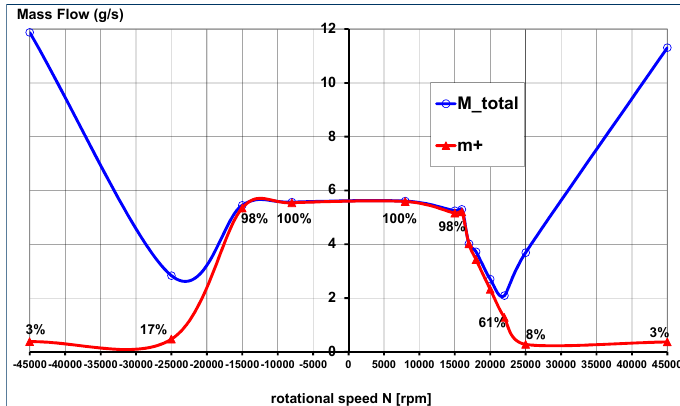
Figure 14. The impact of rotational speed and rotational direction on the flow in a windback seal at a pressure ratio of 1.05.